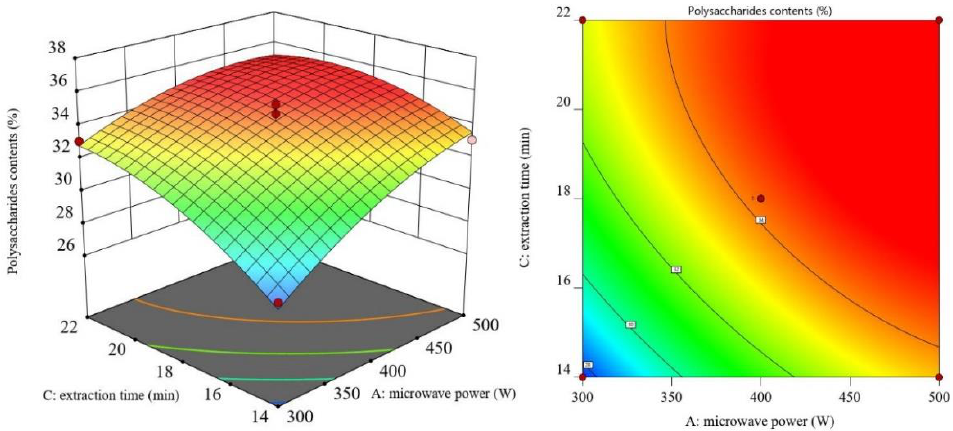
Figure 4. Effect of ultrasound power and extraction time interaction on polysaccharide yield. (A is the microwave power/(W), C is the extraction time/(min)).